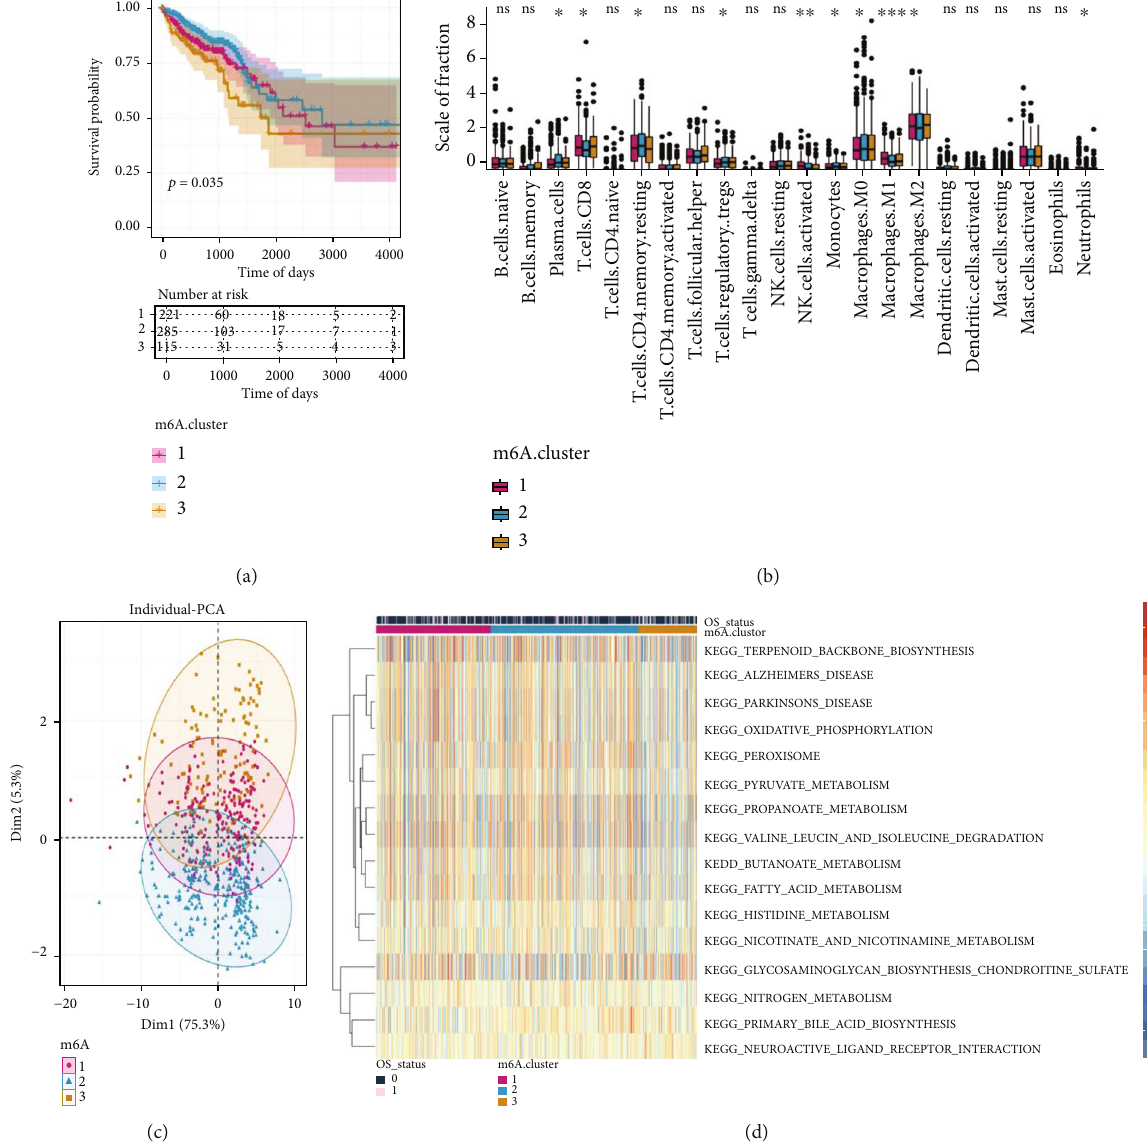
Figure 3: Identi fi cation and functional enrichment analysis of m6A clusters in The Cancer Genome Atlas-colorectal cancer (TCGA-CRC) dataset. (a) Overall survival curves among three m6A clusters. (b) A scatter plot of principal component analysis (PCA) of 21 m6A methylation regulators. (c) Boxplot depicting the relative immune cell in fi ltrations among three m6A clusters. (d) Kyoto Encyclopedia of Genes and Genomes (KEGG) analysis of gene sets among three m6A